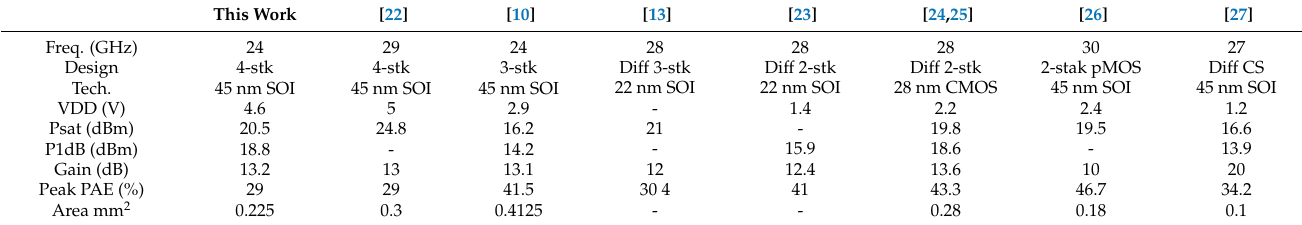
Table 3. Comparison Table of the Recent Integrated Ka-Band Power